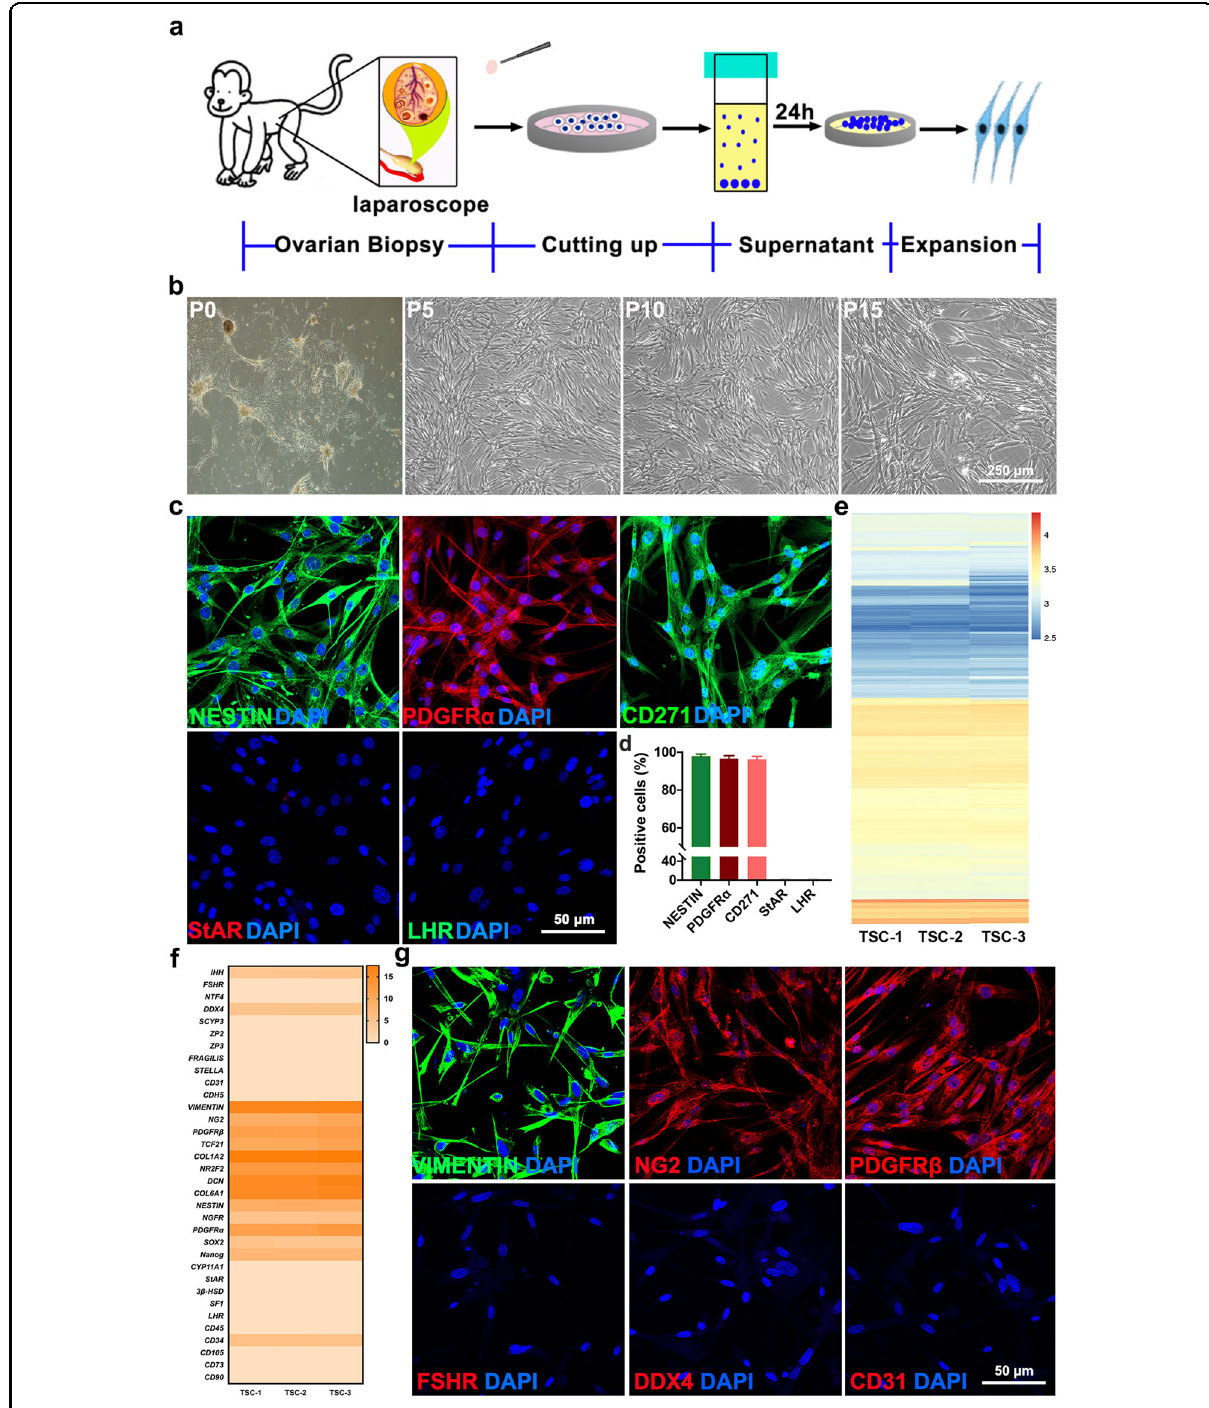
Fig. 1 Isolation and characterization of TSCs from the ovaries of cynomolgus monkeys with POI. a Schematic of the experimental procedure used to obtain primary thecal stem cells (TSCs). b Phase-contrast micrographs of TSCs at primary culture passage 0 (P0), passage 5 (P5), passage 10 (P10), and passage 15 (P15). c Cultured TSCs expressed NESTIN, CD271, and PDGFR α , but not StAR or LHR. Nuclei were counterstained with DAPI (blue). d Statistical analysis of expression markers of TSCs and cell replicates ( n = 3). e Heatmap showed expression of gene for the TSCs ( n = 3). f Heatmap showed expression of marker genes for the major cell types in the TSCs ( n = 3). g Immunostaining showed the TSCs expressed markers about interstitial cells, but not granulose cells, oocytes, and endothelial cells. Data are expressed as the means ±